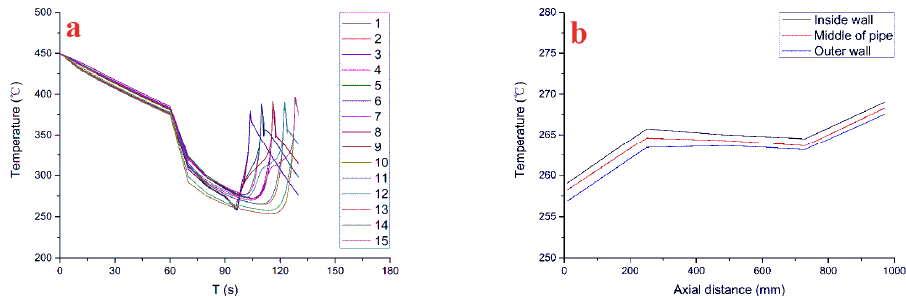
Figure 10. Temperature change at the simulation point. ( a ) Temperature change over time at 15 points at 450 °C–200 °C–5 mm/s; ( b ) Exit temperature variation at 15 extrusion points at 450 °C–200 °C–0.5